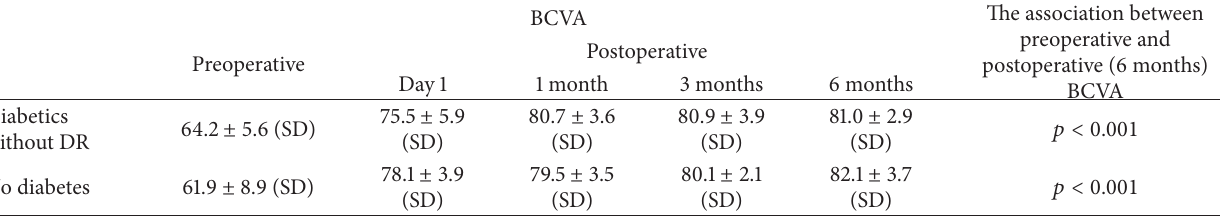
Table 2: Mean best corrected visual acuity (BCVA) in ETDRS letters preoperatively and at all postoperative follow-ups.